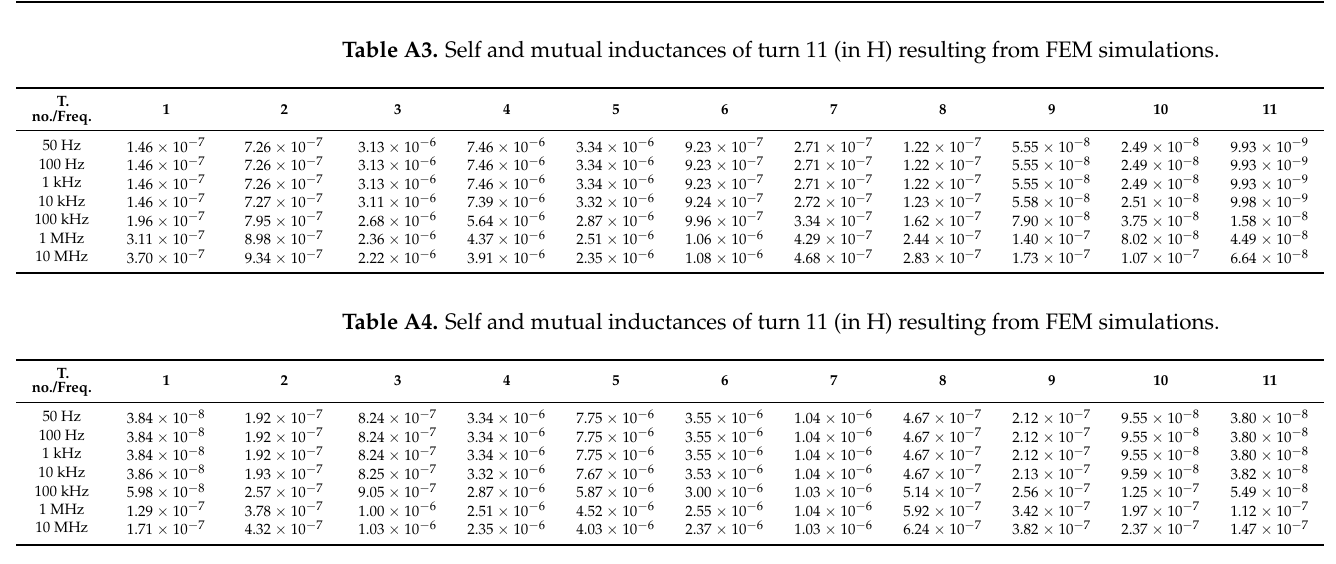
Table A5. Self and mutual inductances of turn 11 (in H) resulting from FEM simulations. T. no./Freq.